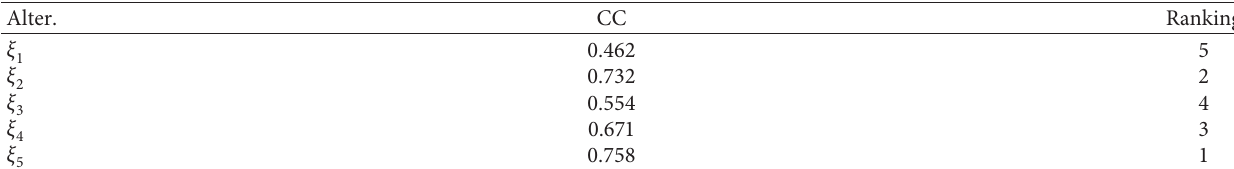
Table 30: Relative closeness coefficient and ranking of each alternative.